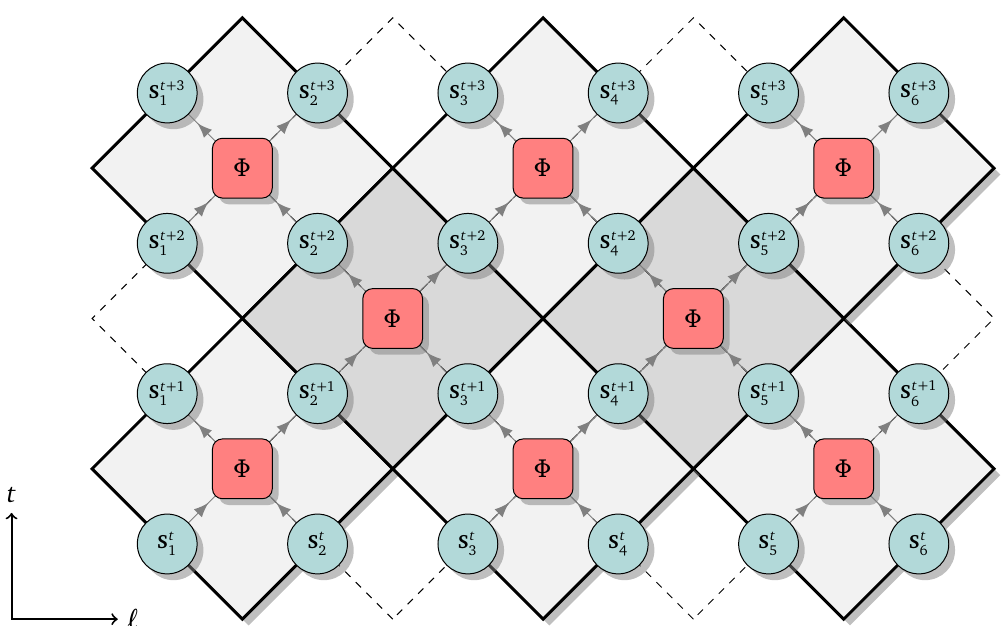
Figure 2: Fabric of discrete space-time: the square space-time lattice comprising classical spin degrees of freedom S t (circles) superimposed on a square light-cone (cid:96) lattice represented by a tilted checkerboard. In the middle of each plaquette, there is a two-body symplectic map Φ (red square) which maps the pairs of physical spin variables forward in